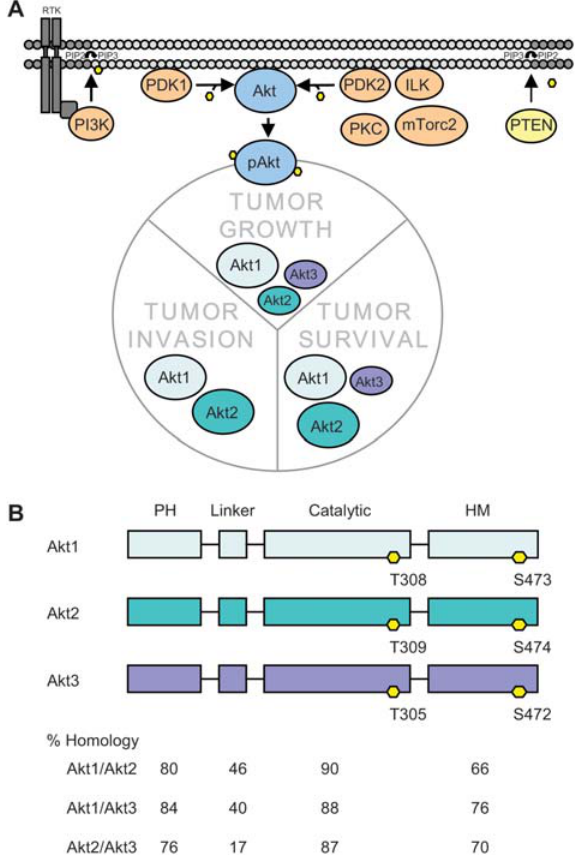
Figure 1 (A) Stimulation of receptor tyrosine kinase (RTK) recruits phosphatidylinositol-3 kinase (PI3K) to the cell membrane to phosphorylate phosphoinositide diphosphates (PIP2) to phos- phoinositide triphosphates (PIP3), a process that is reversed by the phosphatase and tensin homolog (PTEN). PIP3 allows the recruit- ment of Akt to the cell membrane where it is phosphorylated on the threonine 308 (T308) by 3-phosphoinositide-dependent kinase 1 (PDK1) and on the serine 473 (S473) by other kinases such as 3- phosphoinositide-dependent kinase 2 (PDK2), integrin-linked kinase (ILK), protein kinase C (PKC) and mammalian target of the rapa- mycin complex 2 (mTORc2). After full activation, Akt translocates to cytosol and subcellular compartments to phosphorylate different substrates which are involved in tumor growth, cancer cell invasion and chemoresistance. Importance of each Akt isoforms in these pro- cesses is represented by the size of the draw. (B) Akt isoforms sequence composed of a conserved N-terminal pleckstrin homology (PH) domain, a linker domain, a central catalytic domain and a C- terminal regulatory hydrophobic motif (HM) domain, with percent- age of homology and specific phosphorylation